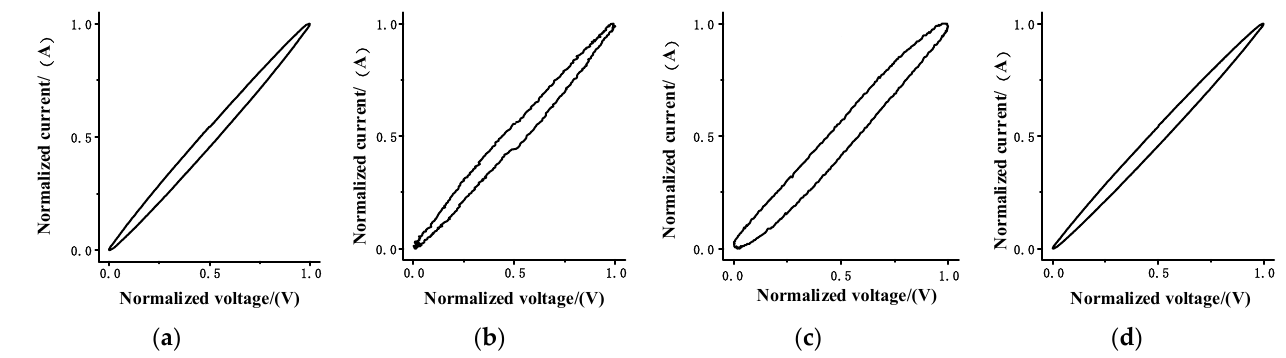
Figure 2. V-I trajectory diagram of similar load for ( a ) coffee maker, ( b ) hair dryer, ( c ) incandescent light bulb, ( d ) kettle.